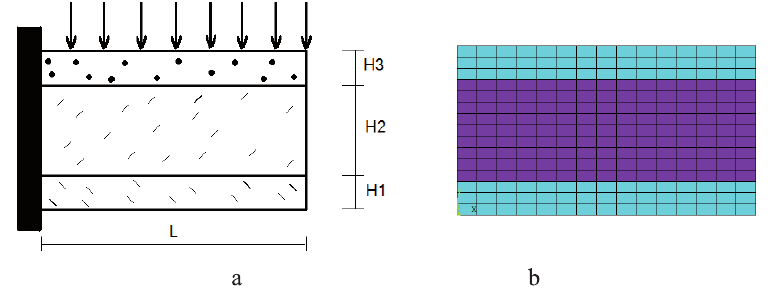
Fig. 6. Layout of tri-material cantilever